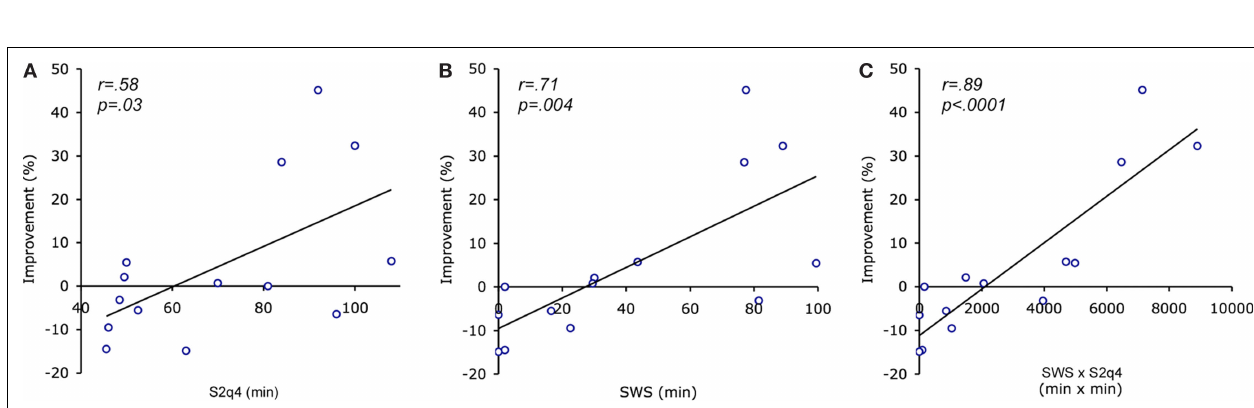
FIGURE 2 | Motor skill learning across training and test trials of the motor sequence task (MST) for healthy control participants ( n = 14, open squares) and schizophrenia patients ( n = 20, closed triangles) from Manoach et al. (2004). The data point for each trial represents the group average. The y -axes represent the number of correct sequences typed in each 30-s epoch. Note that the y -axes are scaled separately for controls (left) and patients (right) to better